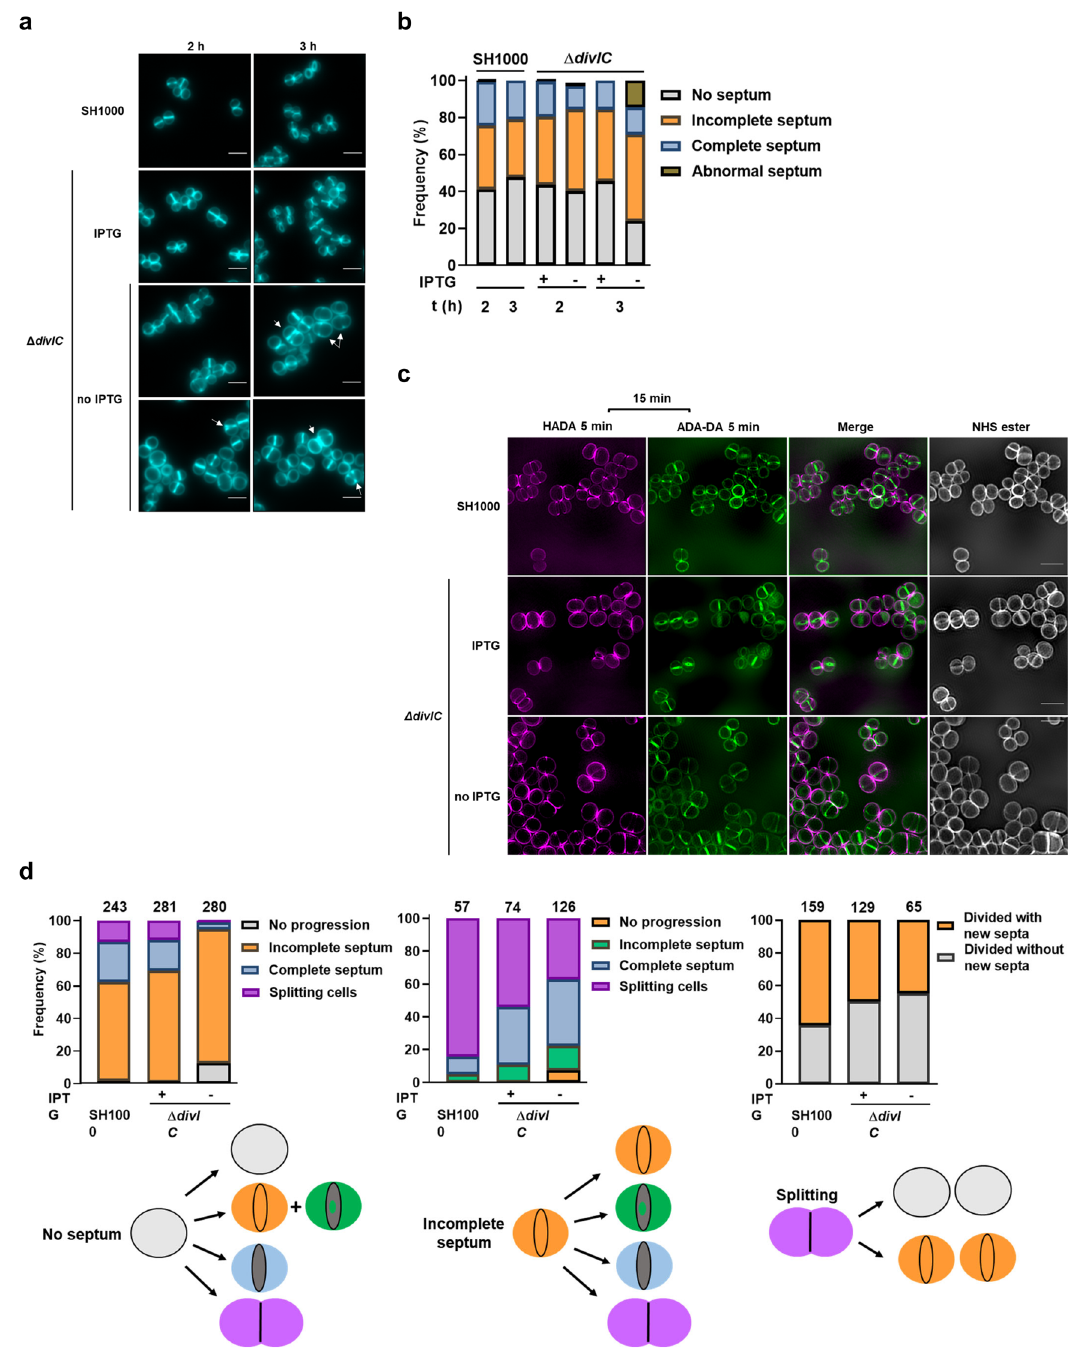
Fig. 2 Loss of DivIC leads to defects in cell division. a Fluorescence microscopy images of SH1000 and Δ divIC (SJF5450) cells grown for 2 and 3 h in the presence and absence of IPTG. PG was labelled by 30 min incubation with HADA. Arrows highlight cells with septal defects. b Quanti fi cation of cellular phenotypes based on HADA labelling (as shown in a), n = 300 cells per sample. c SIM microscopy images of SH1000 and Δ divIC grown in the presence or absence of IPTG. To follow cell cycle progression, after 2 h incubation with or without IPTG, HADA was added for 5 min, cells were washed and incubated for 15 min in fresh medium followed by the addition of ADA-DA for 5 min. Cells were subsequently stained with NHS-ester 555 to show cell morphology. d Cell cycle progression of SH1000 and Δ divIC cells grown with and without IPTG (from c ). Cells with no septum (left panel), incomplete septum (middle panel), and splitting cells (right panel) were identi fi ed by HADA labelling and subsequent cell cycle progression was determined by ADA-DA incorporation patterns based on c . Total number of cells used for each analysis are shown on top of the columns ( n = 459 (SH1000), 484 ( Δ divIC plus IPTG), and 471 ( Δ divIC no IPTG cells)). All images are average intensity projections of z stacks. Scale bars, 2 μ m. Data is representative of two independent